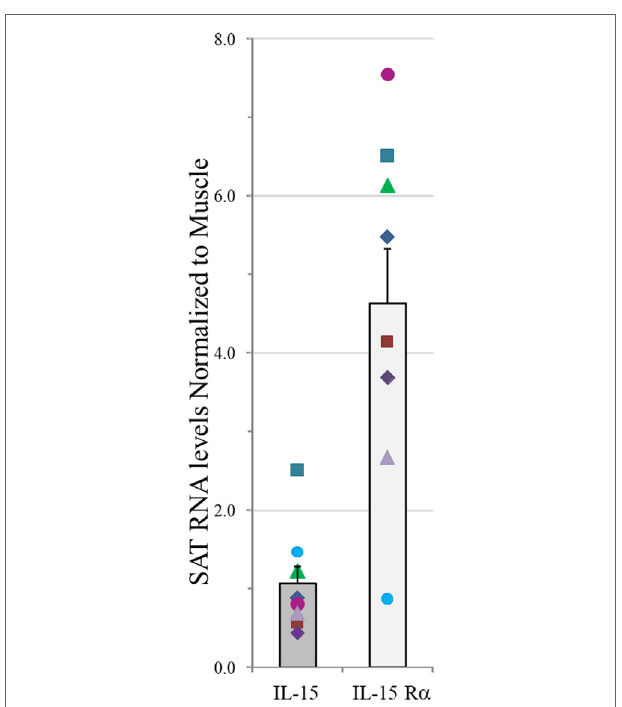
FigUre 1 | IL-15 and IL-15R α RNA levels in abdominal subcutaneous adipose tissue (SAT) normalized to values in paired vastus lateralis muscle samples in measured by RT-qPCR and normalized to four housekeeping genes in cohort A. Shown are means plus SEM. Each symbol for IL-15 and IL-15R α represents an individual donor. IL-15 level did not significantly differ between tissues, but SAT expressed significantly more IL-15R α RNA than did skeletal muscle ( p = 0.012). Cohort A is described in Table S1 in Supplementary